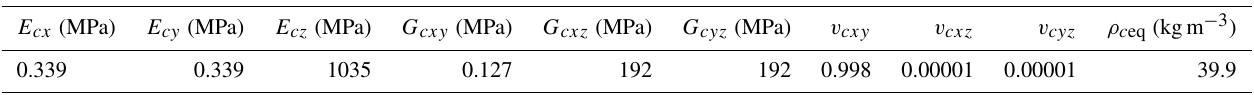
Figure 4. Comparison of the first three natural frequencies between three equivalent simplification methods and fine FE models. Table 1. Equivalent material parameters of the honeycomb core layer of the dynamically equivalent modeling method based on the laminated plate theory (ELM).